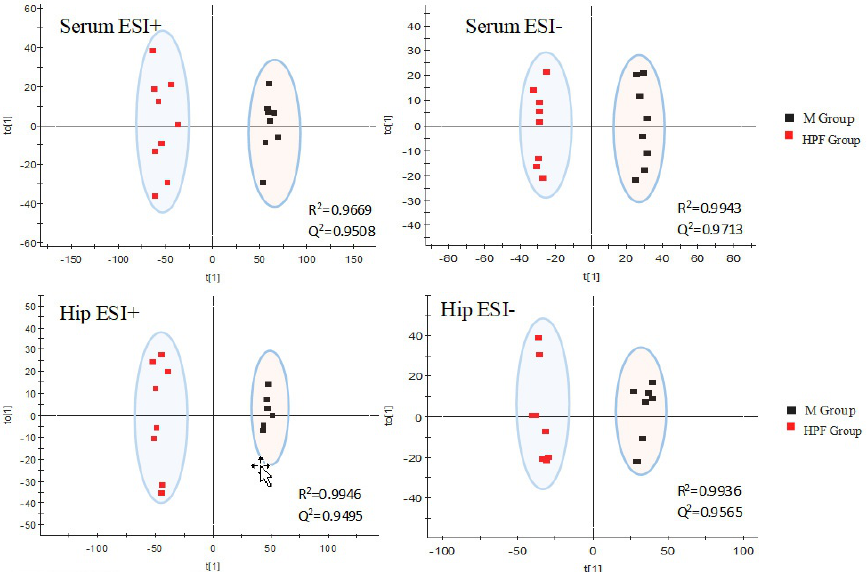
Figure 6. OPLS-DA score plots of serum and hippocampus metabolic profiling of the M and HPF